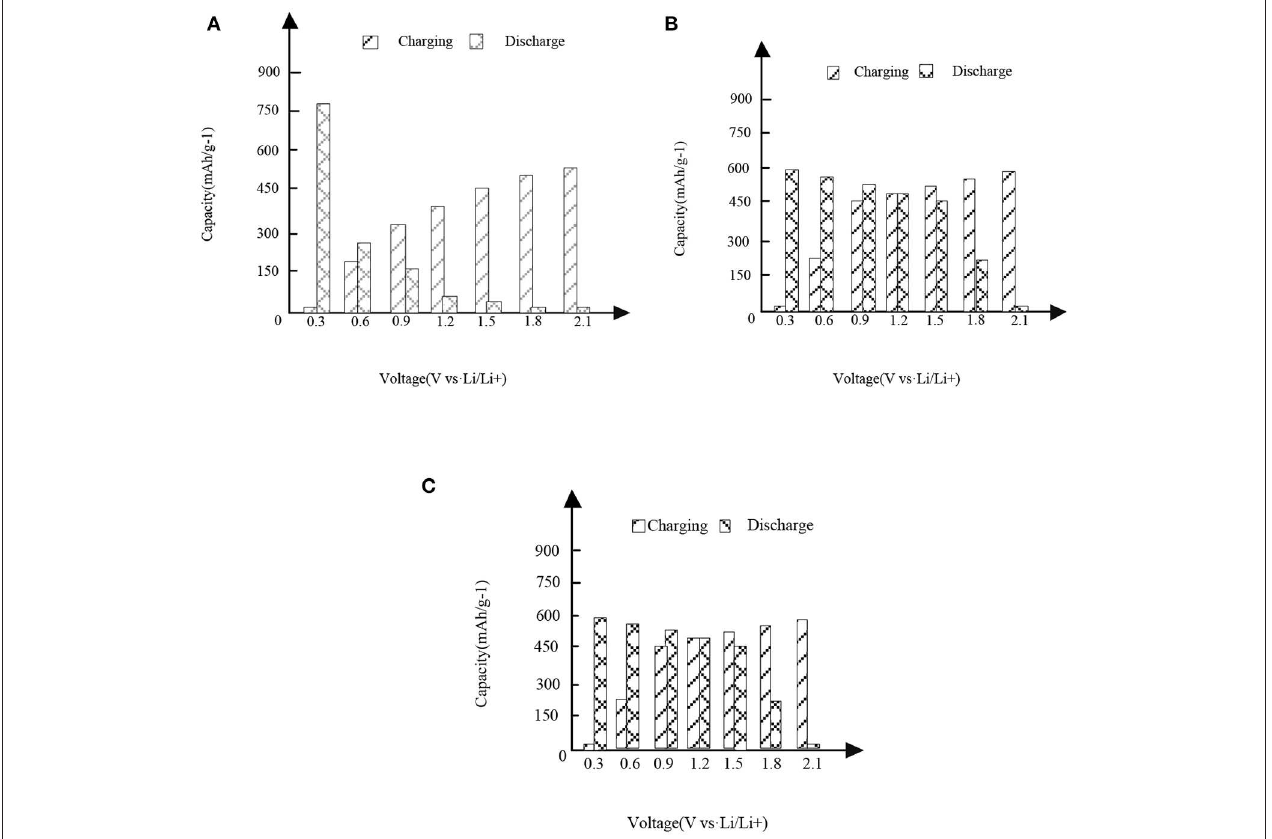
FIGURE 3 | High entropy alloy new material. (A) First charge and discharge. (B) Second charge and discharge. (C) Third charge and discharge.